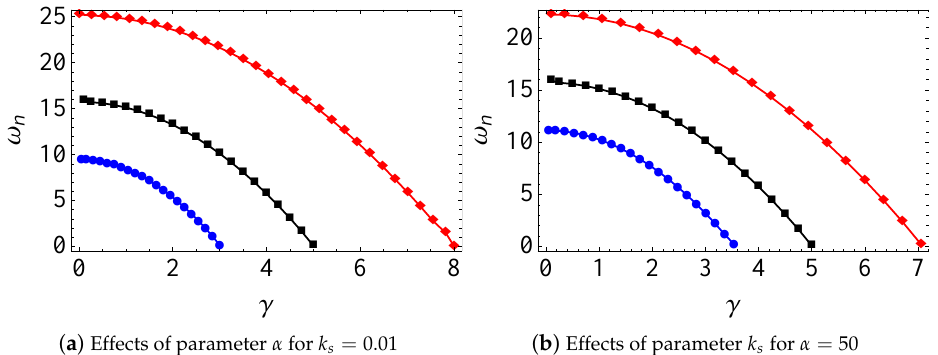
Figure 7. The natural frequency for different α and k s , with ξ 1 = 0.5, p = 0.04 fixed. ( a ) from top to bottom α = 80,50,30; ( b ) from top to bottom k s =